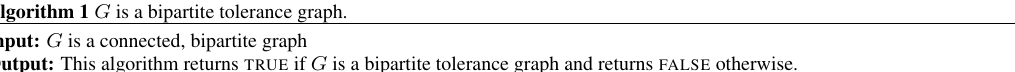
Algorithm 1 G is a bipartite tolerance graph.